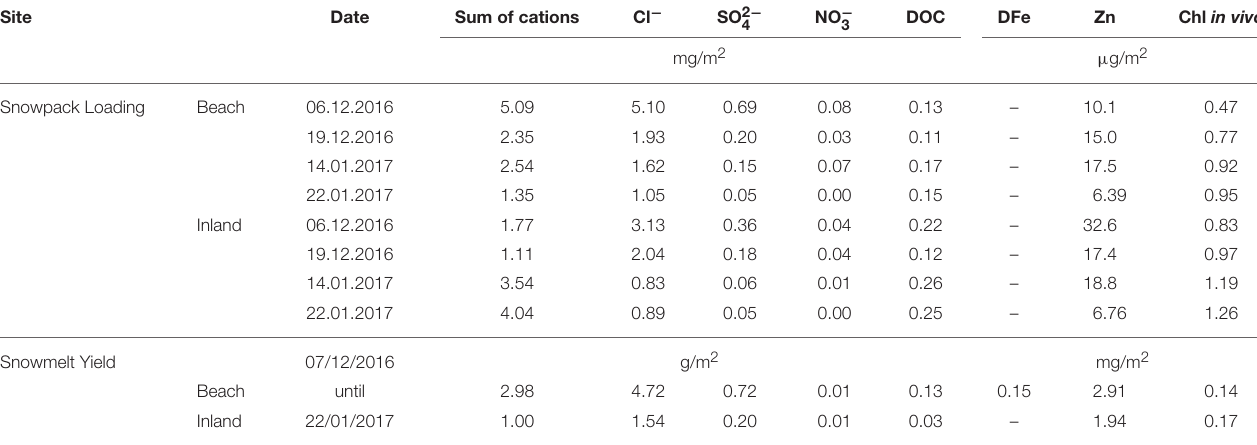
TABLE 4 | Loadings and yields of selected dissolved ions, dissolved organic carbon as well as in-vivo chlorophyll in the snowpack and their corresponding snowmelt at the beach and the inland sites. Site